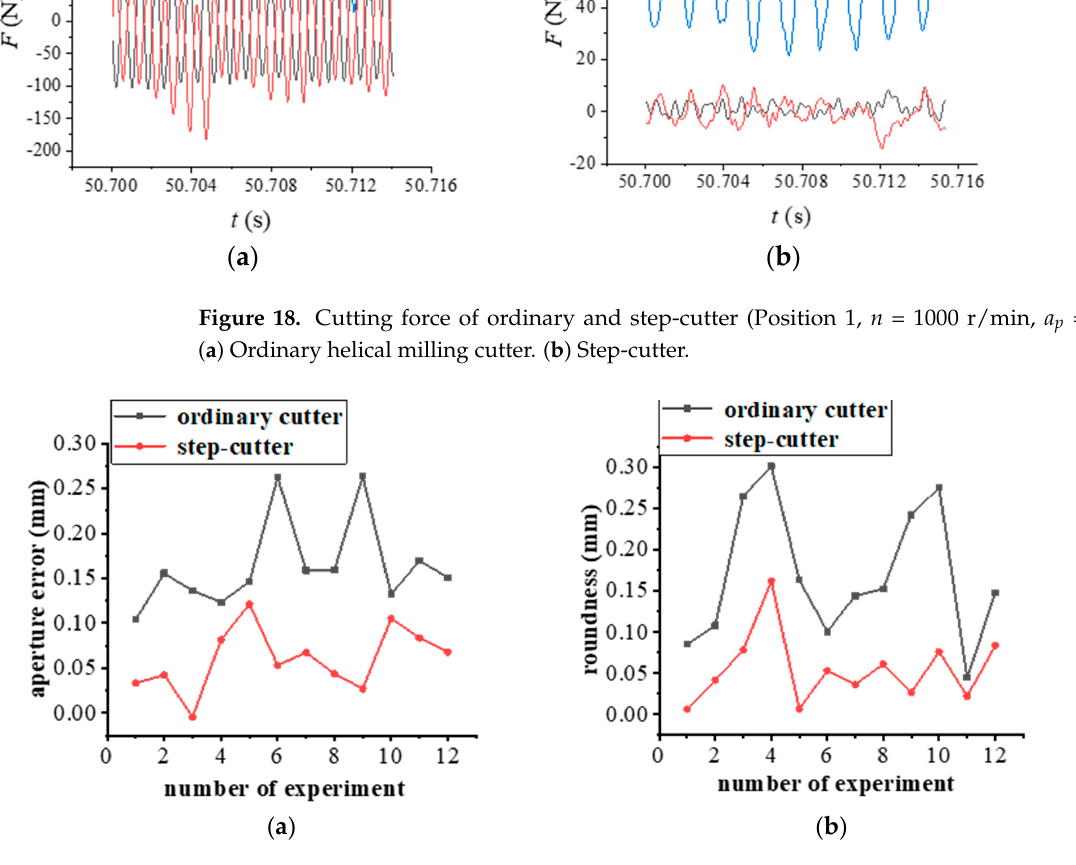
Figure 18. Cutting force of ordinary and step-cutter (Position 1, n = 1000 r/min, a p = 0.2 mm). ( a ) Ordinary helical milling cutter. ( b ) Step-cutter.